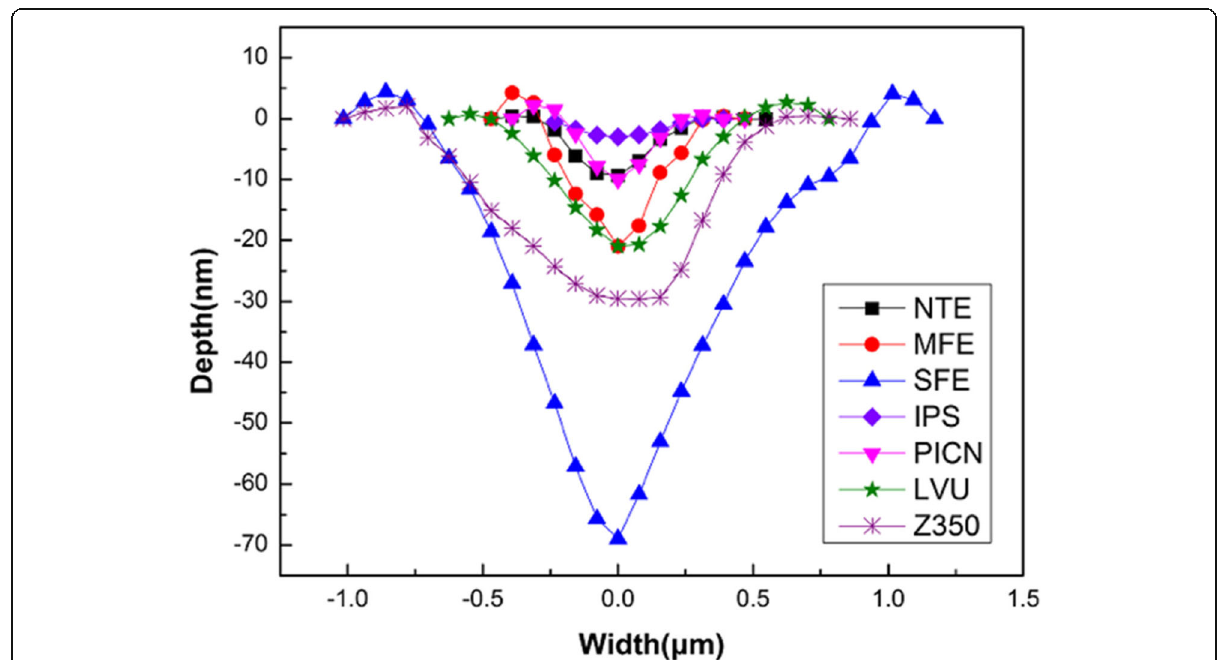
Fig. 9 Profiles of nanoscratch tracks on the outer enamel of the normal tooth, mild dental fluorosis, and severe dental fluorosis and